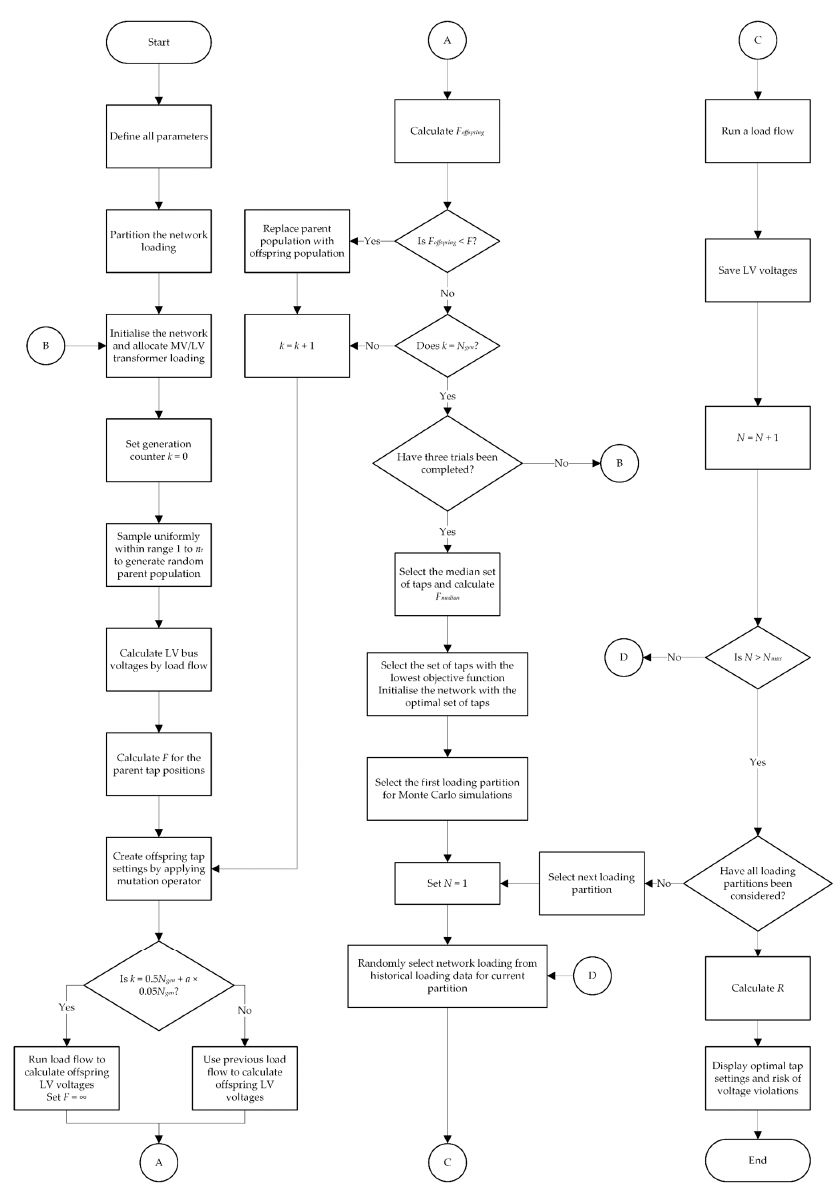
Figure 2. Flow chart of the algorithm . Reproduced from [1], IEEE: 2019.